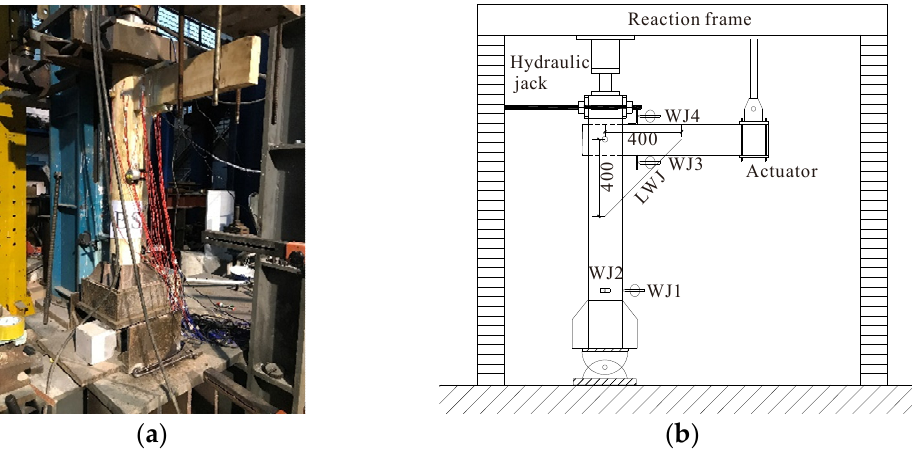
Figure 11. Loading equipment: ( a ) On-site loading and ( b ) Sketch.